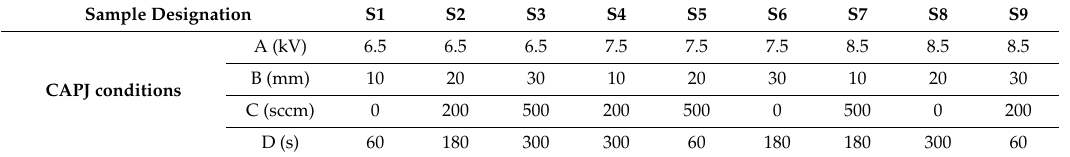
Table 3. The Taguchi L9 sample designation and detailed CAPJ